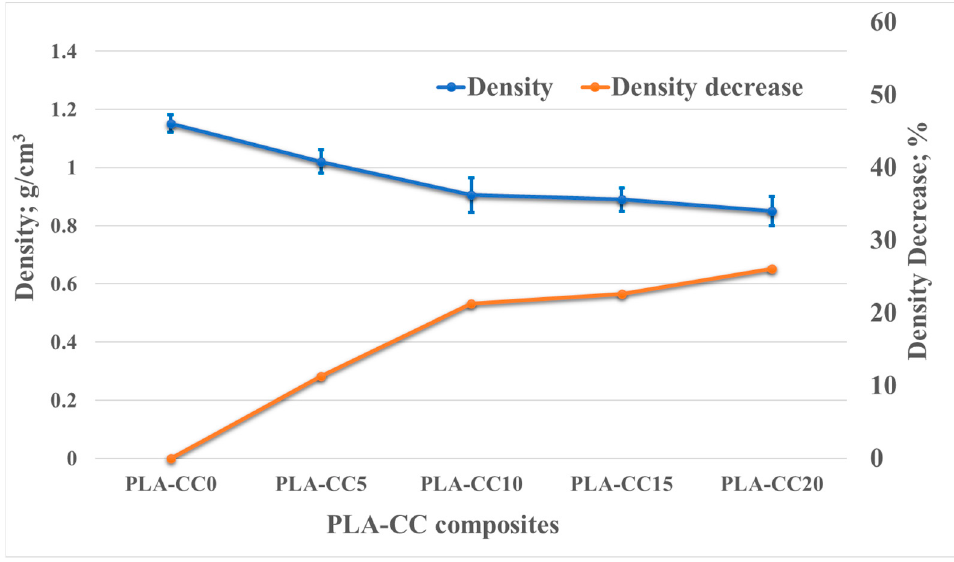
Figure 7. PLA-CC composites densities for different corn cob weight fractions.